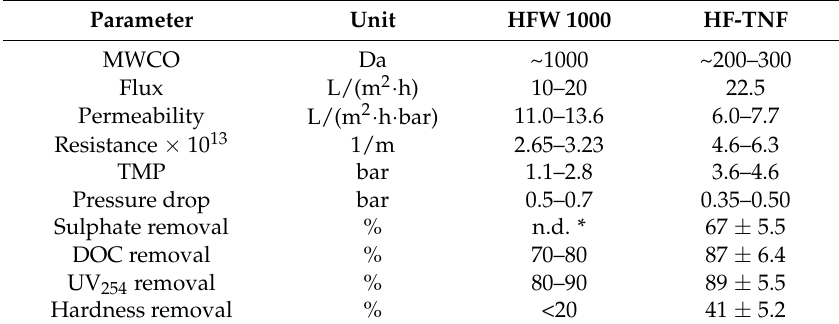
Figure 6. Feed and permeate concentrations of selected OMP; well water as feed; for permeate <LOQ the 1 LOQ was used. 2 Table 3. Comparison of commercial available module HFW 1000 with new developed membrane HF-TNF using literature data [40,41] and data from pilot